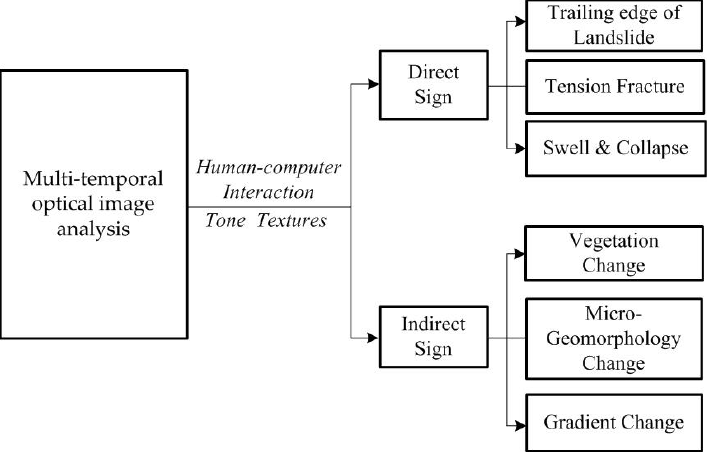
Figure 2. Flowchart of the proposed landslide interpretation method of optical images.